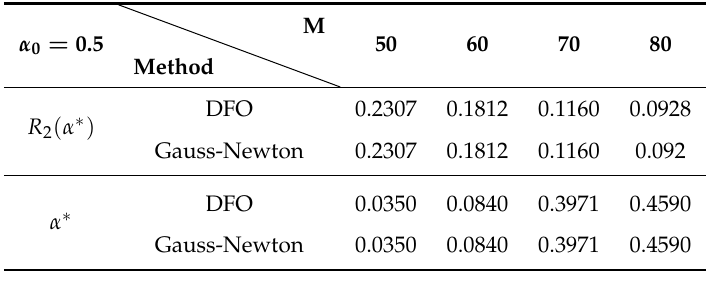
Table 2. The results of the Gauss–Newton method and the DFO method on different M values with α 0 =